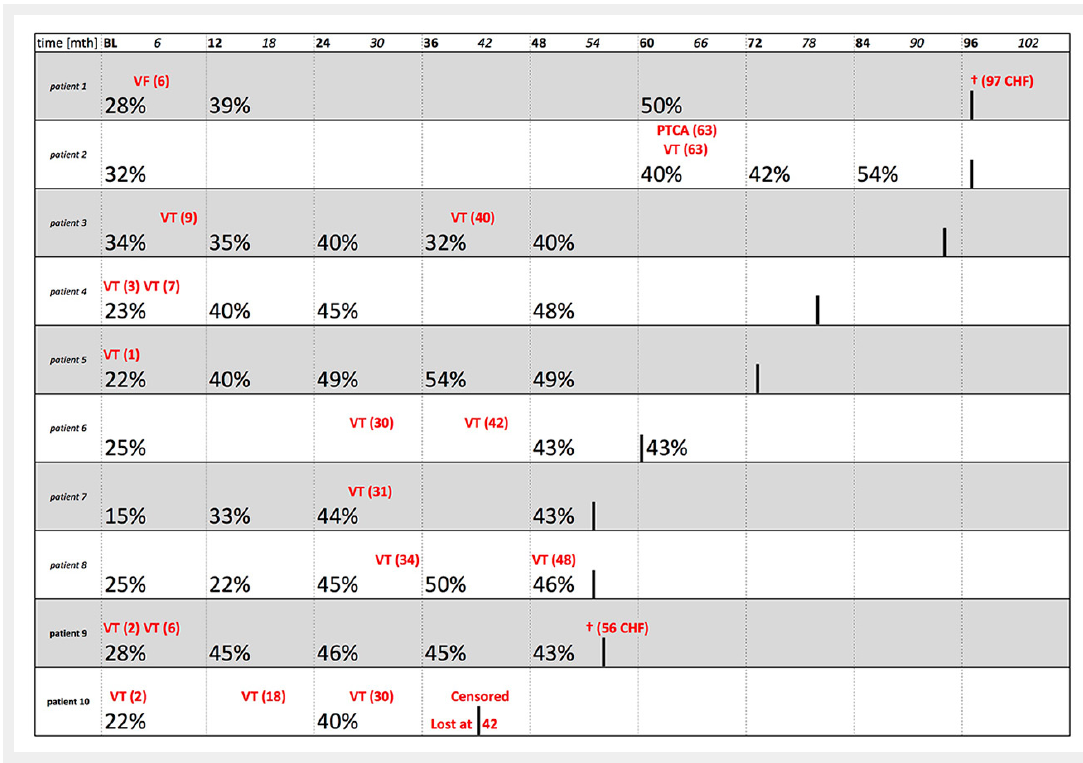
Figure 5 Time line of the 10 patients who improved to >40% and who had events. Brackets indicate time from implantation in months. † = death; BL = baseline; CHF = congestive heart failure; VF = ventricular fibrillation; VT = ventricular